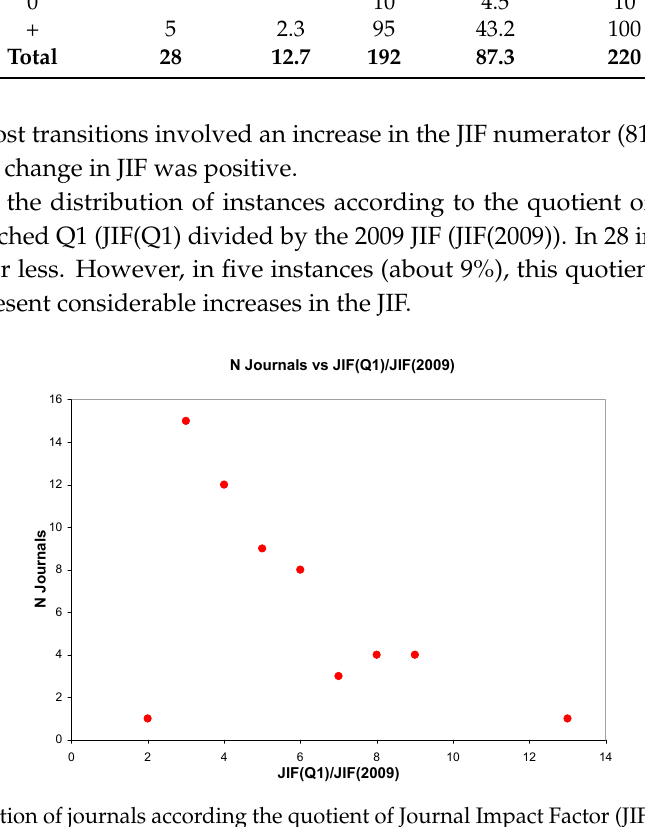
Figure 1. Distribution of journals according the quotient of Journal Impact Factor (JIF) in the year when it entered the first quartile (Q1), JIF(Q1), divided by the 2009 JIF, JIF(2009).